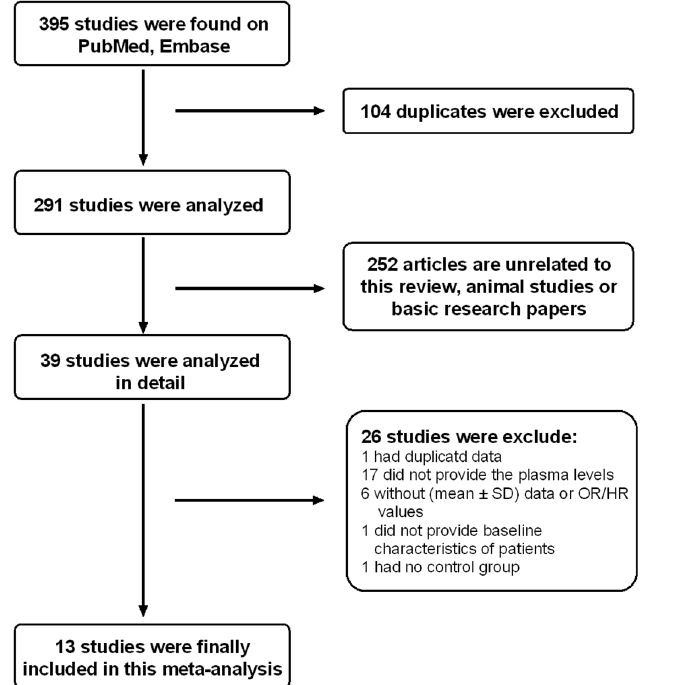
Fig 1. Flow chart of study selection. SD, standard